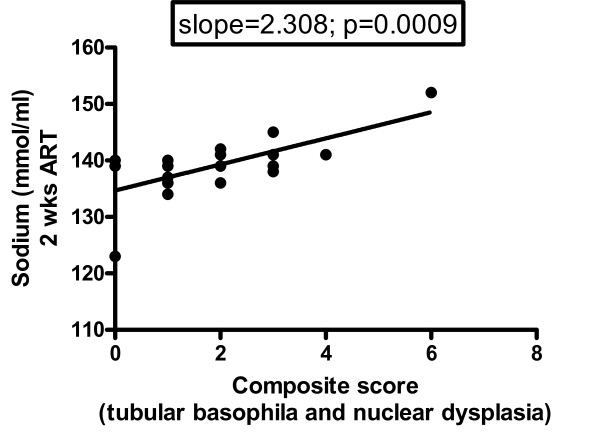
Relationship between serum sodium levels at 2 wks of ART and ongoing pathology within the proximal convoluted tubules at death.